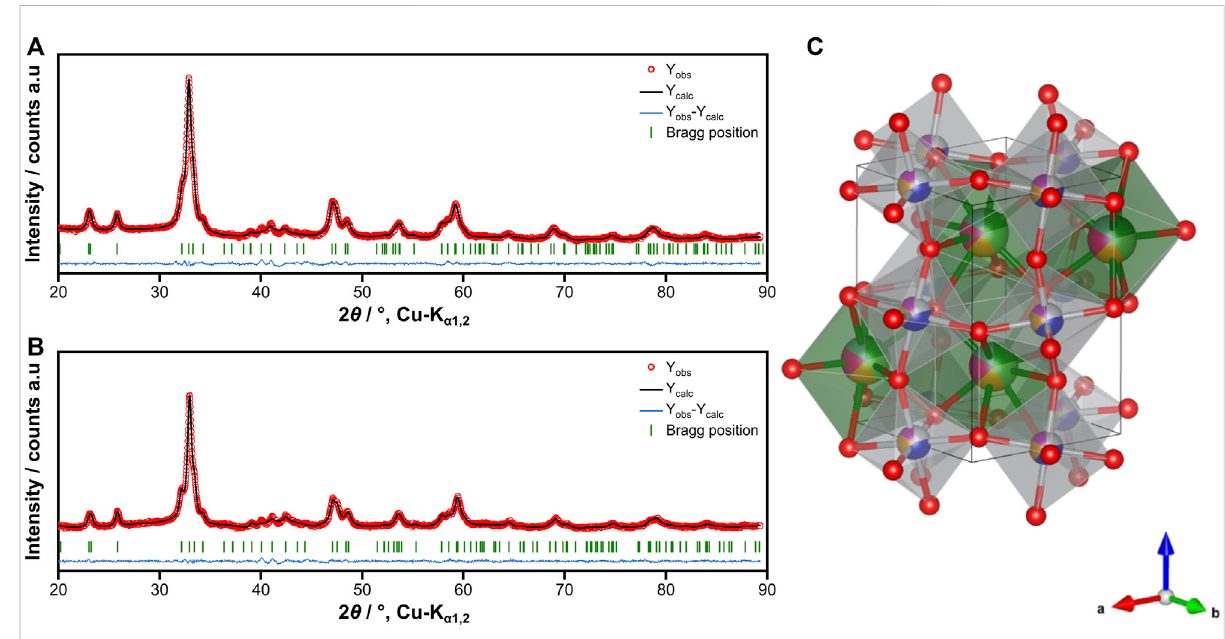
FIGURE 1 XRD patterns and Rietveld re fi nement of the ball mill synthesized (A) HEO-La and (B) HEO-Sr. (C) Model for the HEO unit